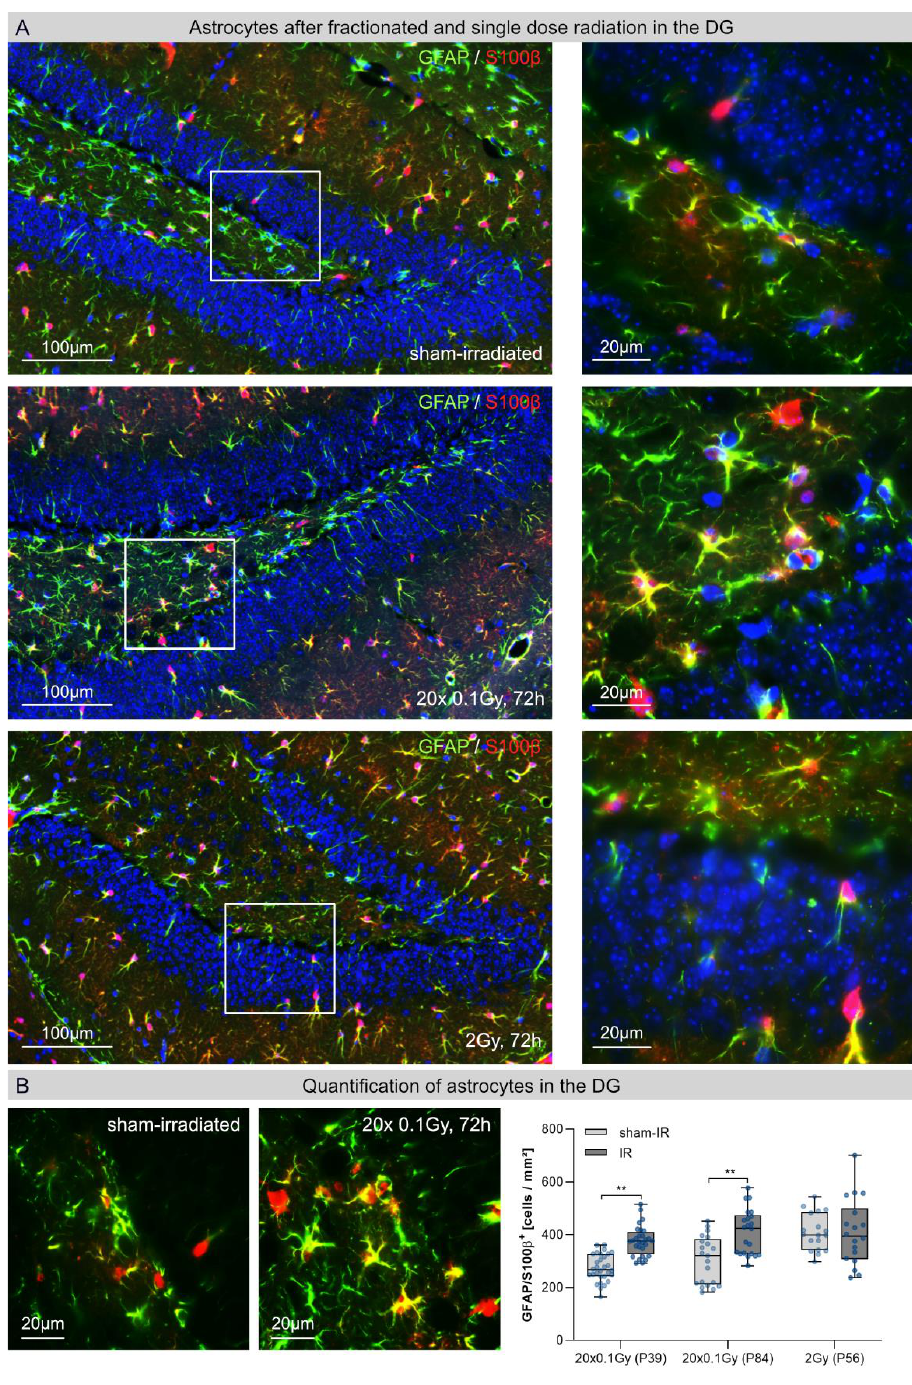
Figure 3. Astrocytes in the hippocampal entate gyrus (DG) after fractionated low-dose and single- dose radiation. ( A ): Immunofluorescence micrographs of GFAP+ (green)/ S100β+ (red) astrocytes in the DG of sham-irradiated (upper panel), fractionated low-dose irradiated (20 × 0.1 Gy, 72 h post-IR; middle panel) and single-dose irradiated (1 × 2 Gy, 72 h post-IR; lower panel) brains. Framed regions are shown at higher magnifications. Insets: following FLDR, reactive astrocytes showed star-shaped morphologies. Original magnification: 600×. ( B ): In the DG of juvenile and adult brains, the numbers of GFAP+/S100β+ astrocytes cell s were quantified after 20 × 0.1 Gy versus 1 × 2 Gy (72 h post-IR), in comparison to age-matched, sham-irradiated controls. Error bars represent SEM, n ≥ 3; * denotes statistically significant difference compared to sham-irradiated control: ** p < 0.01.